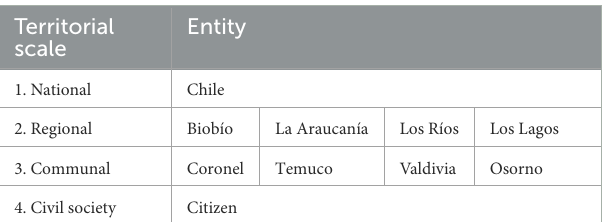
TABLE 1 Territorial entities considered in the case